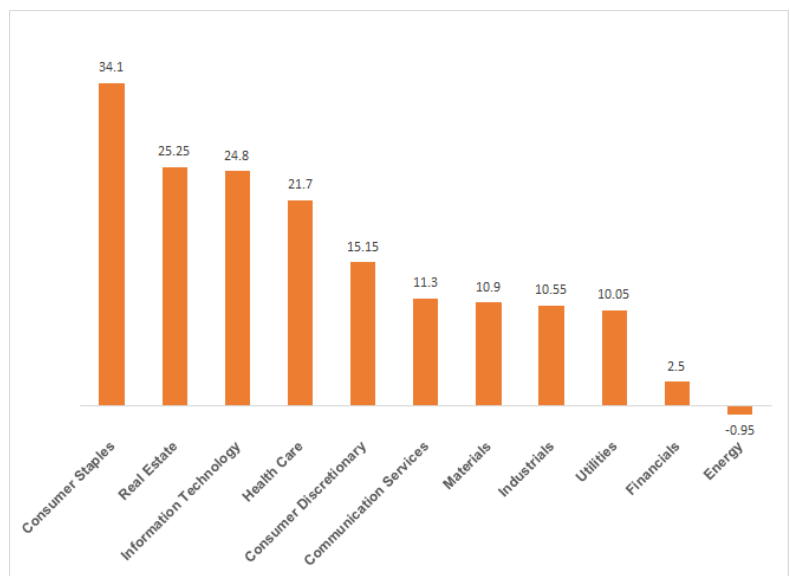
Figure 7. Growth rate of Relevant ESG mentions between 2016 and 2018 for various sectors.